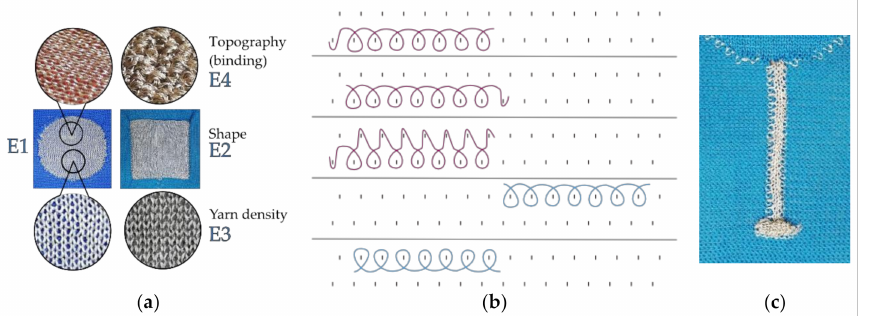
Figure 2. ( a ) The four different electrode versions E1–E4. ( b ) Excerpt from simplified technical drawing of knitting binding for electrode E4 with tuck stitch variation. The pink loops are made from conductive yarn to create the electrode area, while the blue yarn is non-conductive PET to knit the surrounding fabric. ( c ) Integrated textile lead with a tail in the